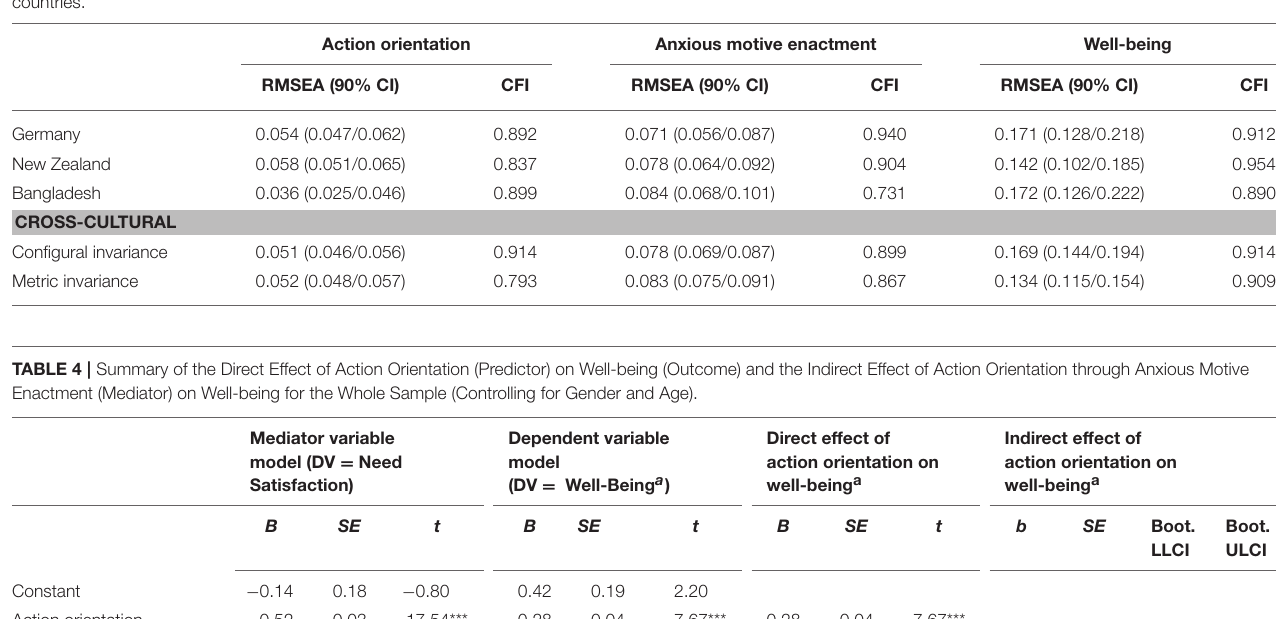
TABLE 3 | Model Fit Indices for Confirmatory Factor Analyses (CFA) in the Three Sample Groups and the Multigroup Confirmatory Factor Analysis (MGCFA) across countries.